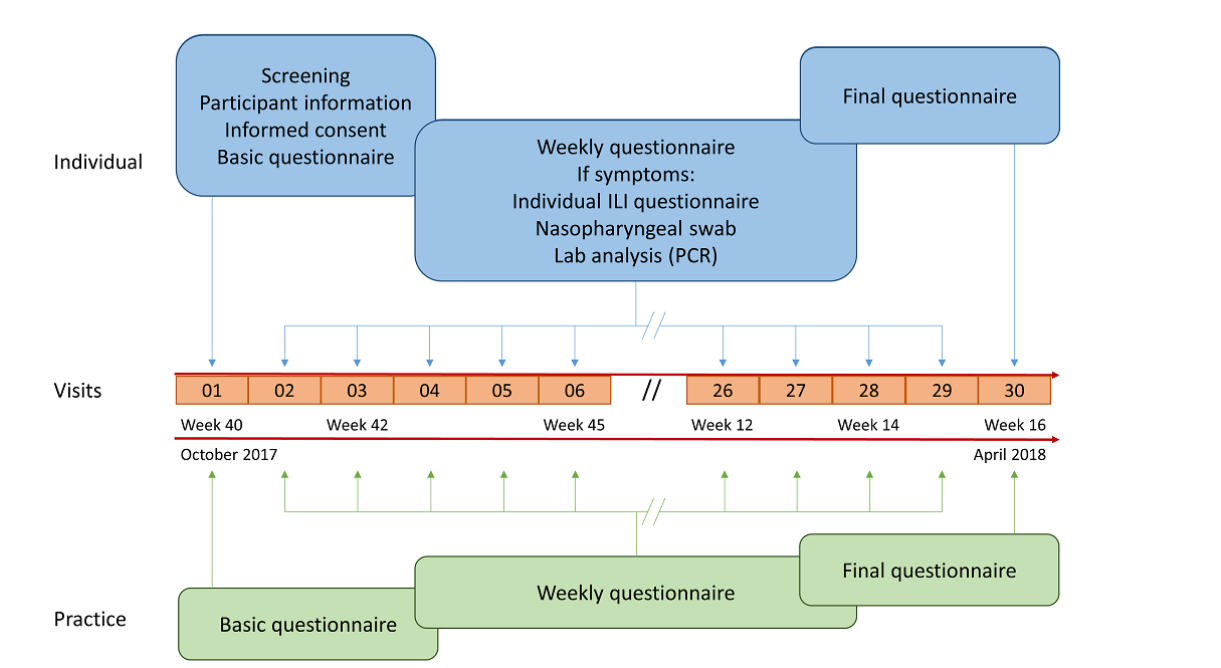
Figure 1. Outline of the study. ILI: influenza-like illness; PCR: polymerase chain